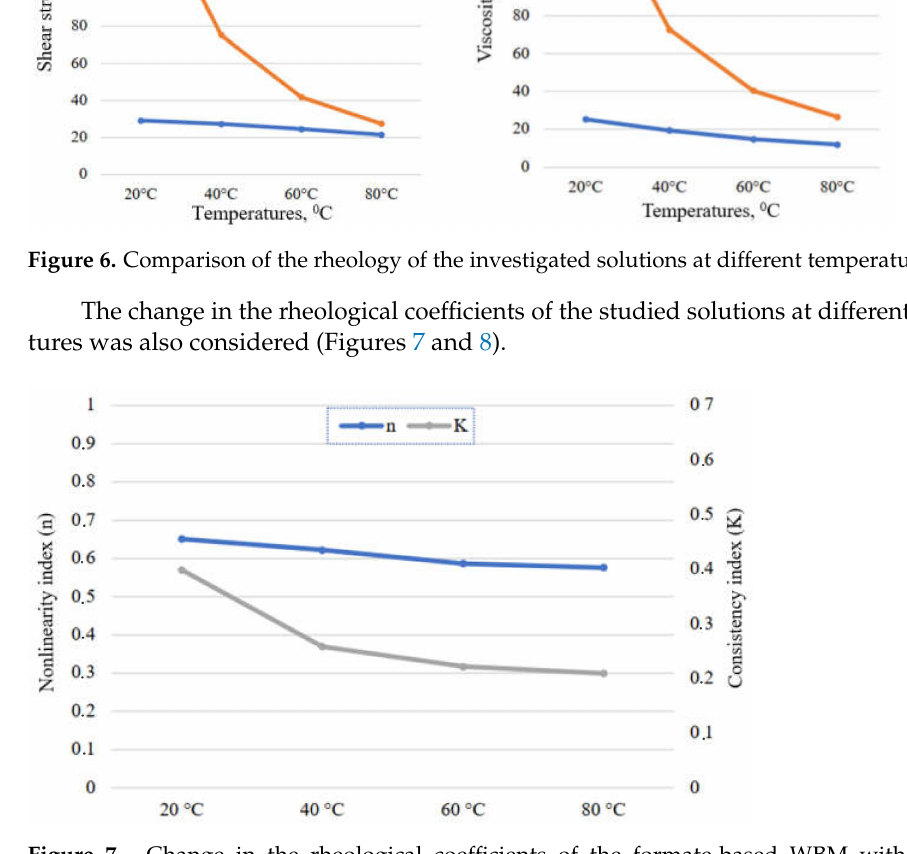
Figure 7. Change in the rheological coefficients of the formate-based WBM with PHPA at different temperatures.